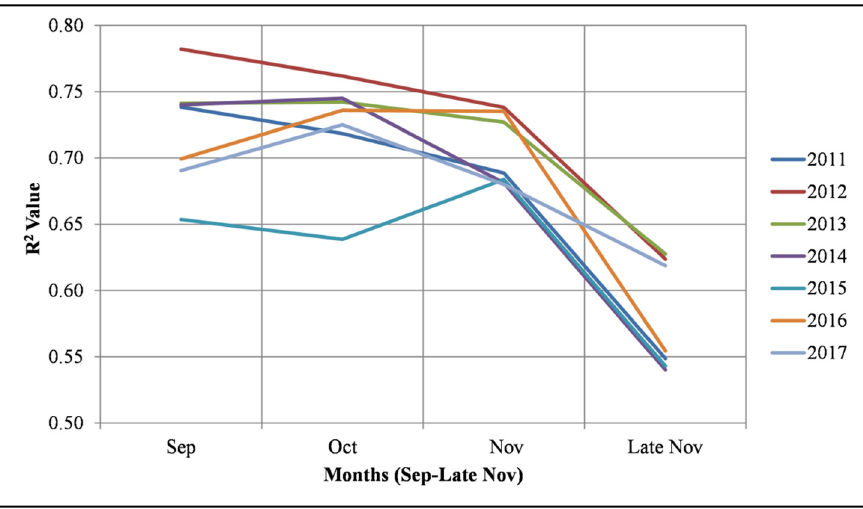
Figure 4. Variations of monthly derived remote sensing regression models (2011–2017).